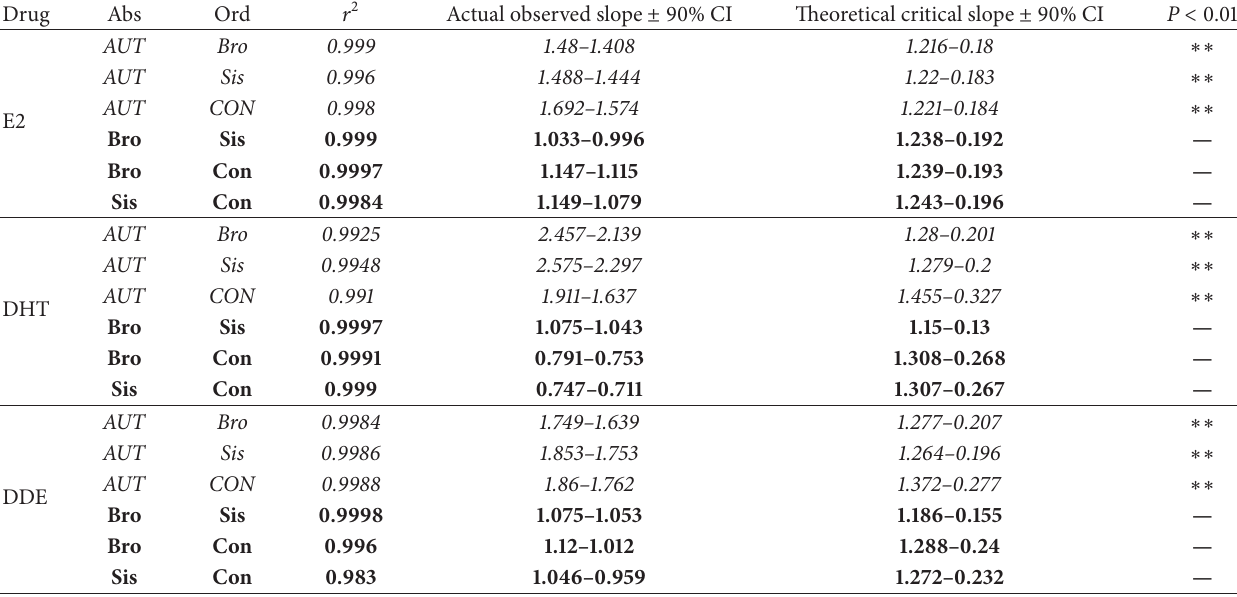
Table 2: Comparison of cell growth cumulative sum